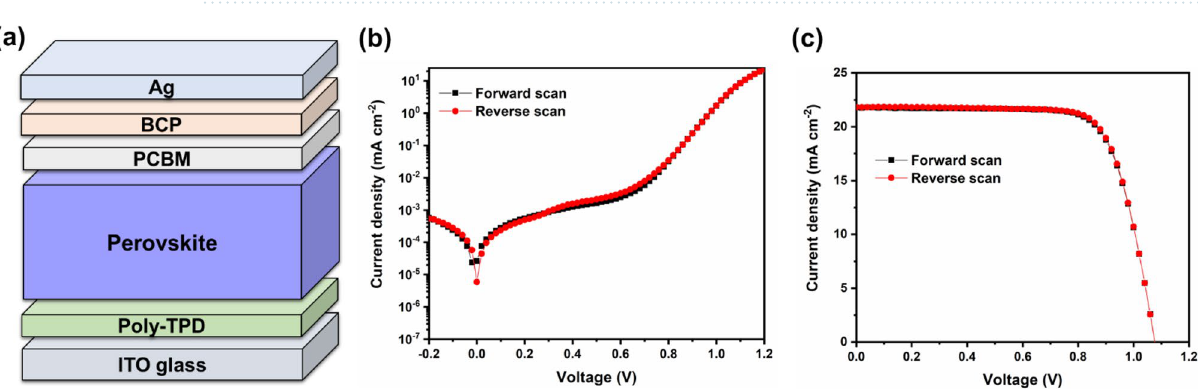
Figure 5. Spectra of: ( a ) PL; and ( b ) TRPL of the prepared perovskite thin films for samples 1–6.